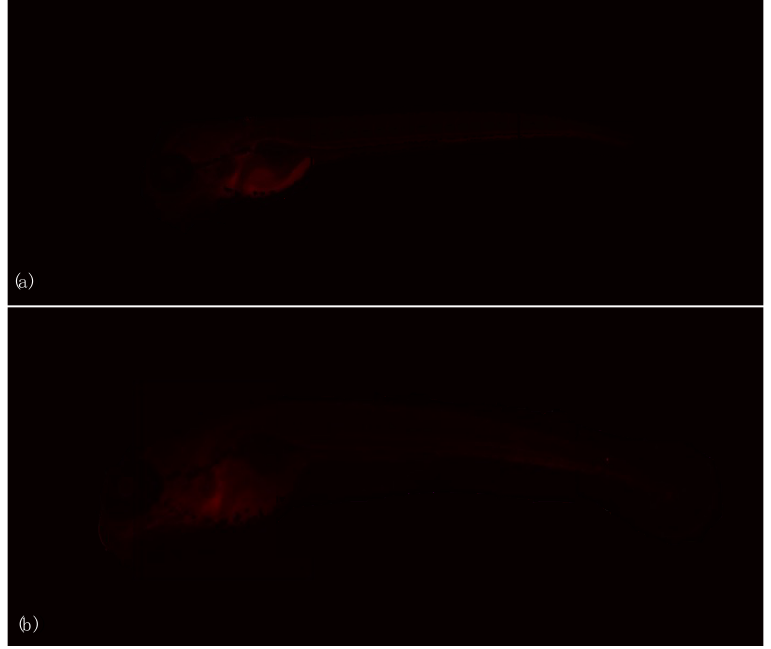
Figure 5. Immunohistochemical investigation of P540 biomarker in larvae unexposed ( a ) (CTRL) and exposed ( b ) (EXP) to 27 GHz at the end of exposure.